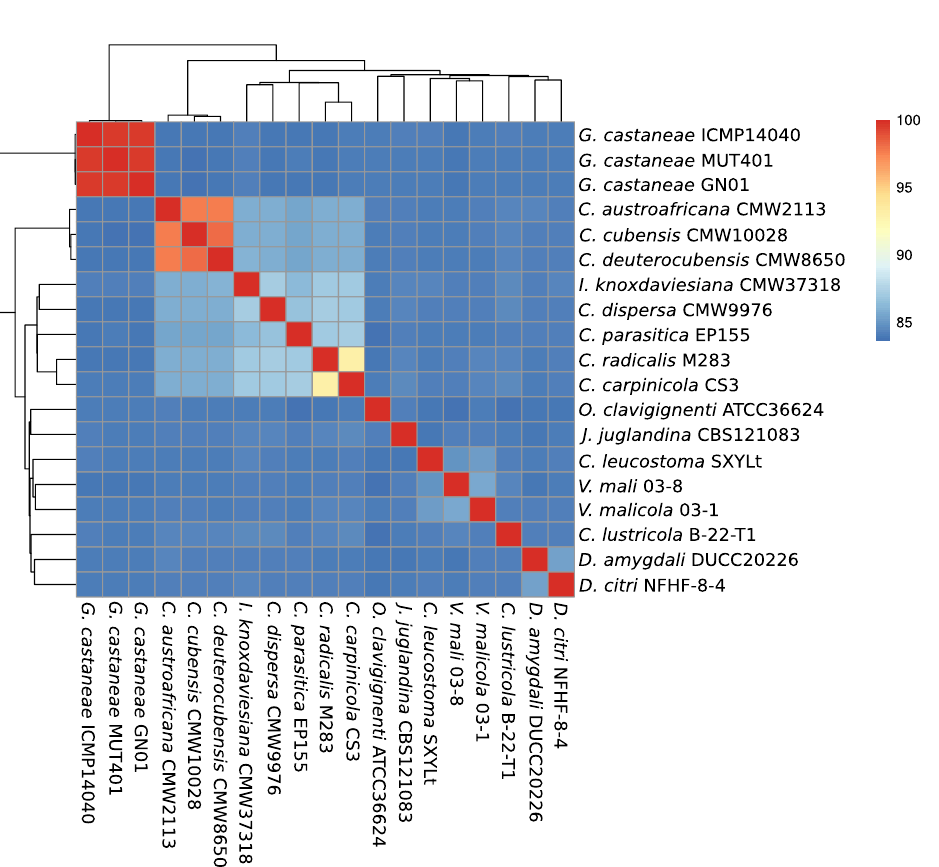
Figure 3. Heatmap of the Average Nucleotide Identity (ANI) analysis performed with the pyANI script and MuMMER showing the percentage of identify among the different